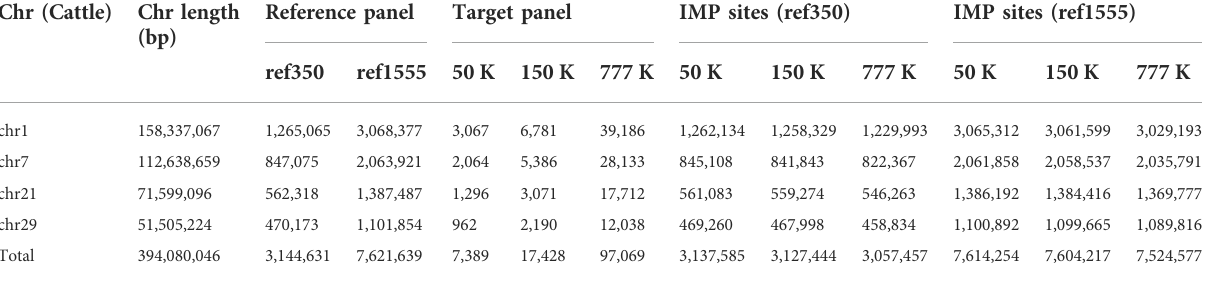
TABLE 1 Number of SNPs used across chromosomes under different panels in cattle. Chr